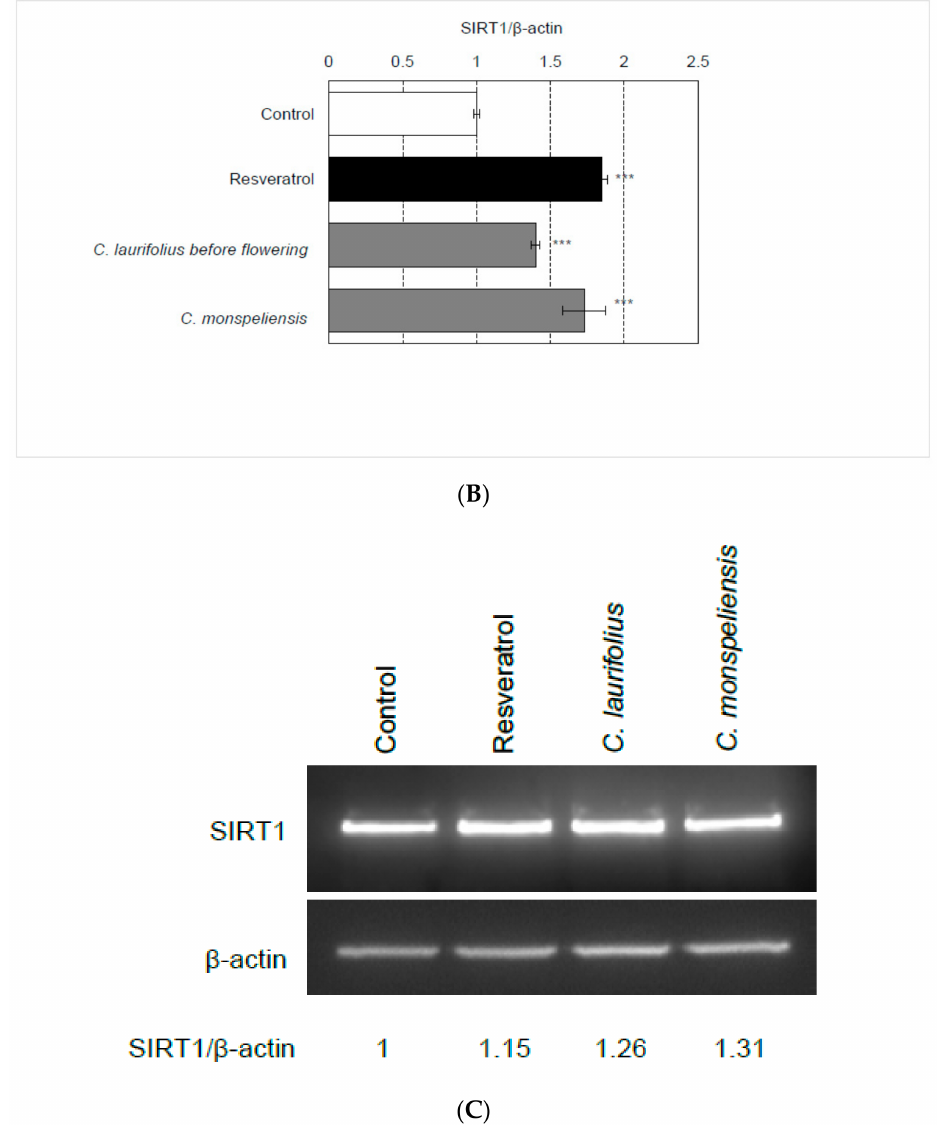
Figure 1. Effects of essential oils on the expression of SIRT1. ( A ) Essential oils (final concentration: 100 ng/mL) were added to the HaCaT (SIRT1p-EGFP) cells and cultured for 48 h; then, changes in EGFP fluorescence were monitored. ( B ) Effects of essential oils on the expression of endogenous SIRT1 in HaCaT cells evaluated by qRT-PCR. Statistical significance was determined by using a two-sided Student’s t -test. Statistical significance was evaluated by comparison with the control and defined as p < 0.05 (* p < 0.05; *** p < 0.001). Values are means ± SEM ( n = 3). ( C ) Effects of essential oils on the expression of SIRT1 protein in HaCaT cells evaluated by Western blot. As a control treatment, HaCaT cells were treated with dimethyl sulfoxide